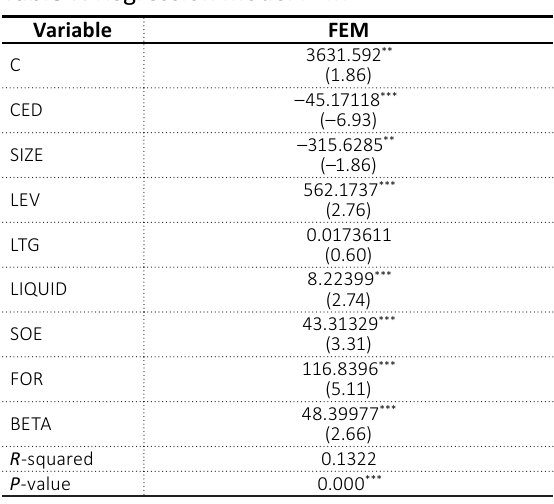
Table 7. Regression model